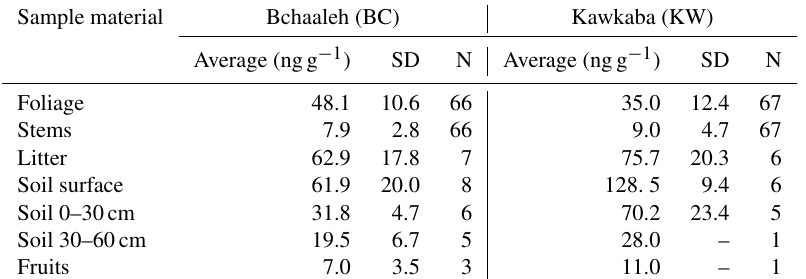
Table 1. Overall mean values of Hg concentration (ngg − 1 ) of the different studied material in both Bchaaleh and Kawkaba olive groves.